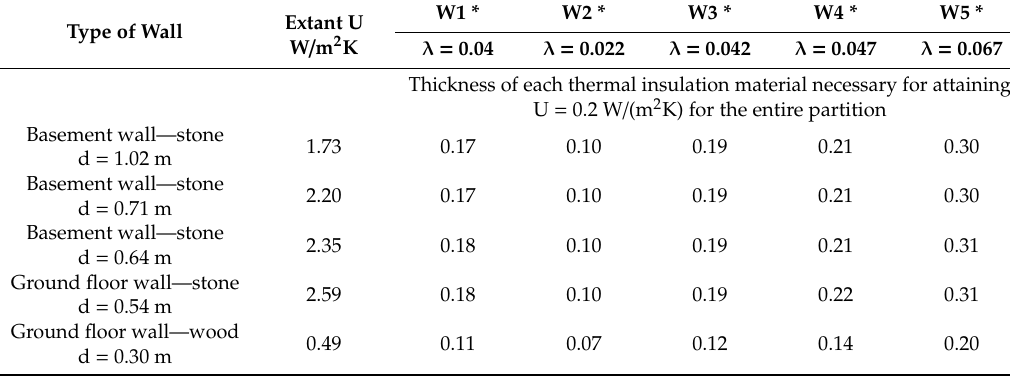
Table 2. Required thermal insulation layer thicknesses for the materials under analysis